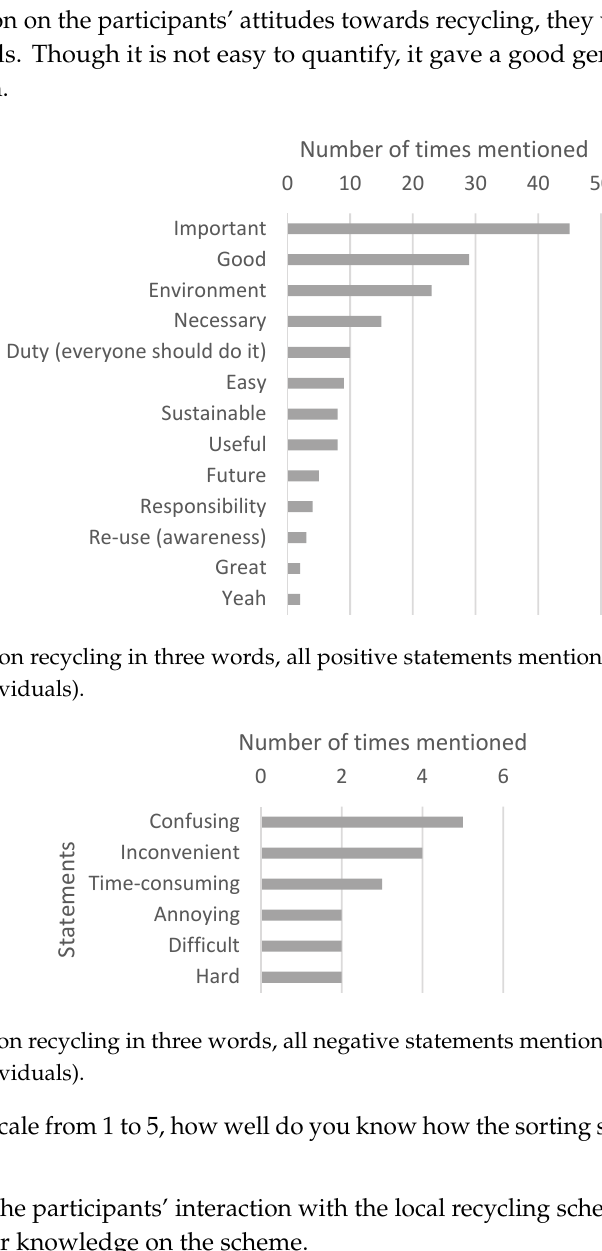
Figure A5 . Perceived personal waste sorting behavior, first survey (106 individuals).